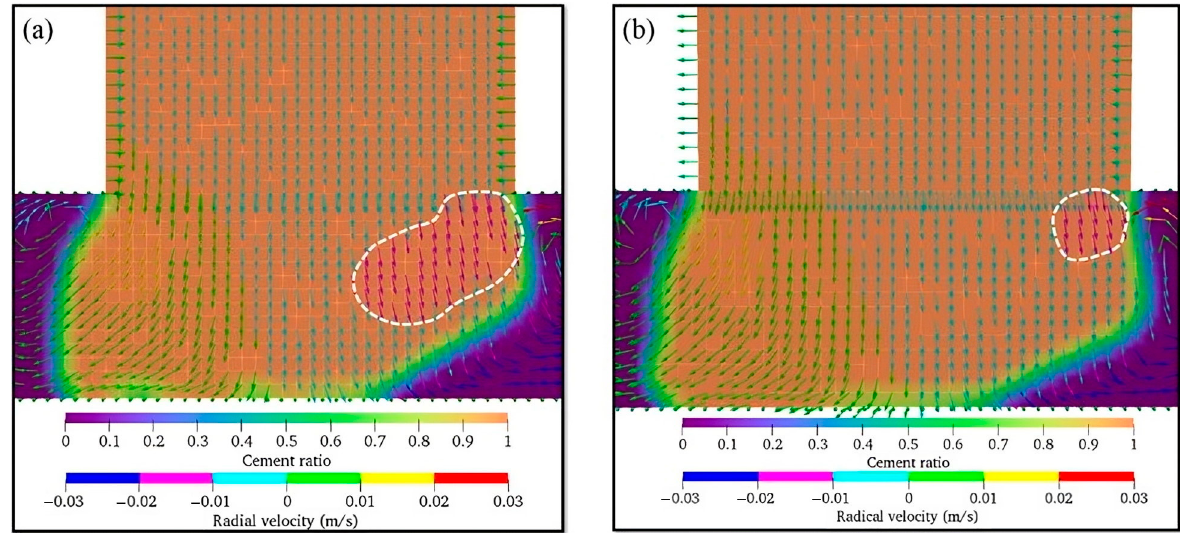
Figure 7. Cement ratio and velocity vector using a trapezoidal nozzle of LR of ( a ) 1.0 and ( b )